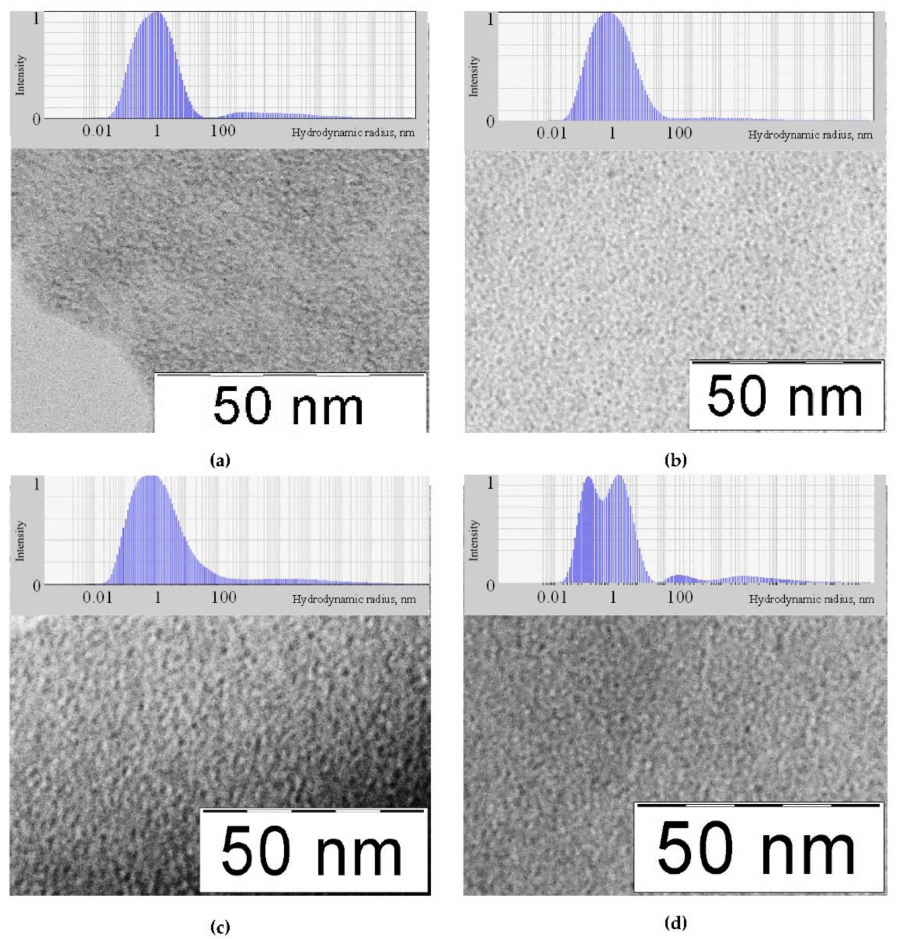
Figure 1. TEM image and dynamic light scattering (DLS) particle size distribution of molybdenum-tungsten blues with di ff erent molar ratio: ( a ) [Mo] / [W] = 95 / 5, ( b ) [Mo] / [W] = 90 / 10, ( c ) [Mo] / [W] = 80 / 20, ( d ) [Mo] / [W] = 50 /